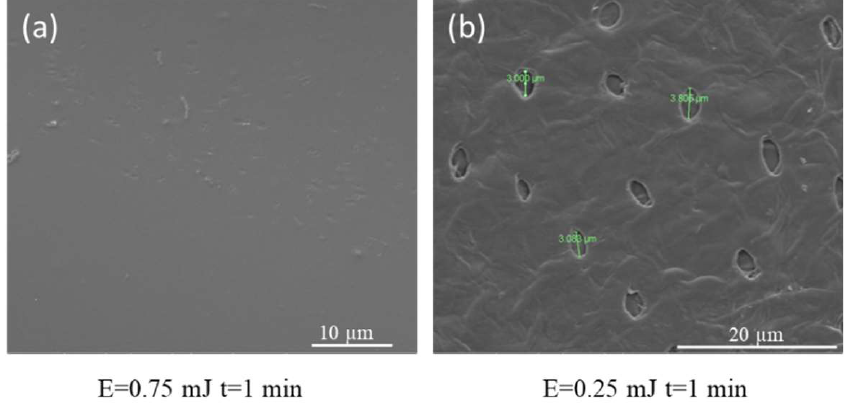
Figure 9. SEM images of GelMa hydrogels (Irgacure 0.05% and GelMa 10% w / v ) obtained after 1 min UV-pulsed laser radiation exposure at energies of ( a ) 0.75 mJ and ( b ) 0.25 mJ. sure at 0.75 mJ do not possess physical pores; instead they have a smooth and homogeneous morphological structure. The interconnected structure of hydrogels gives them specific properties such as the ability not to dissolve in a solvent and the capacity to retain